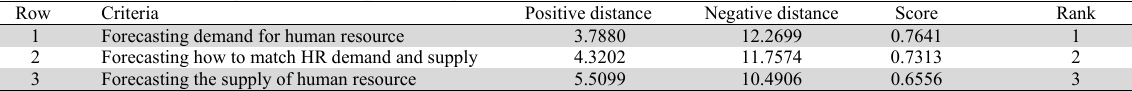
The results of ranking the HRM planning sub-criteria Row Criteria